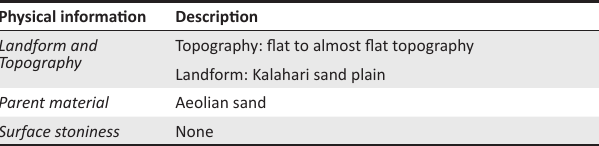
TABLE A1.6a: Differentiating characteristics of haplic Arenosols.